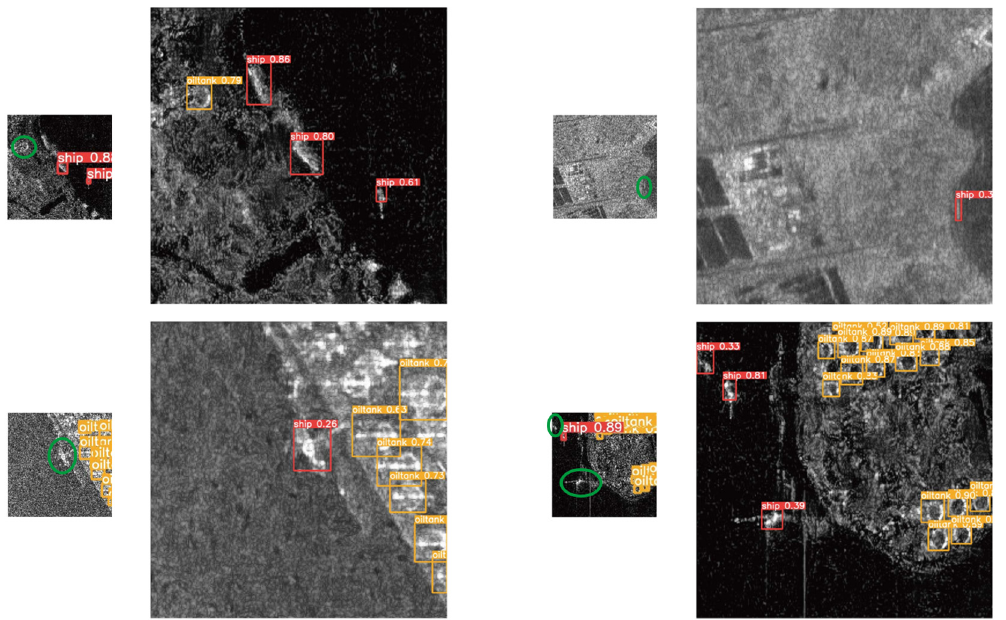
Figure 13. Illustration of missing detection. Green circles mark the position of missing detection. The left insets are the detection results without the SR process. Different colors means different kinds of